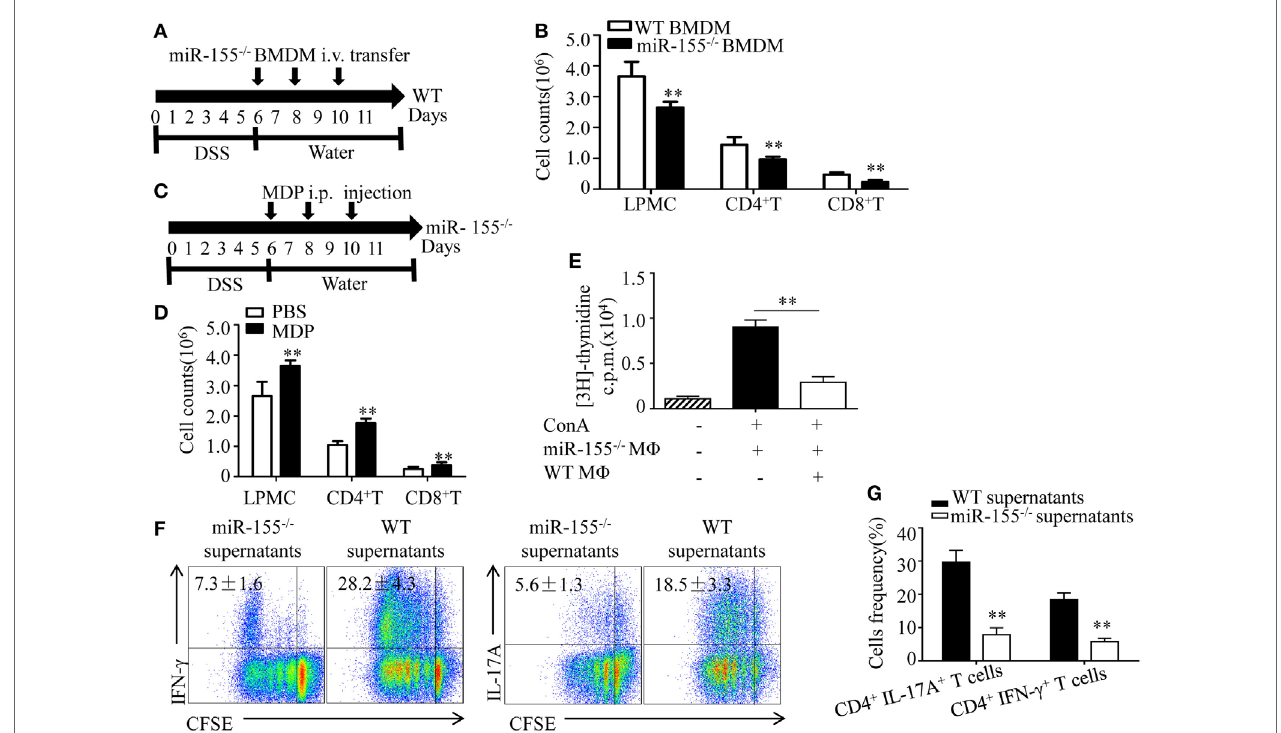
FigUre 5 | miR-155 − / − macrophages inhibit inflammatory cells and shape Th1/Th17 polarization (a,B) WT ( n = 5) mice with dextran sulfate sodium (DSS) colitis were adoptive transferred with miR-155 − / − BMDMs or WT BMDMs (5 million/mouse) as schematic protocol indicated. The total number of LPMCs, CD4 + T cells, and CD8 + T cells of colon tissues at day 11 were counted. (c,D) miR-155 − / − mice ( n = 5) with DSS colitis were i.p. injected with clodronate-liposomes (MDP) or control PBS-liposomes (PBS) as the schematic protocol indicated, and the total number of LPMCs, CD4 + T cells and CD8 + T cells of colon tissues at day 11 were counted. (e) OT-II mice splenocytes with incorporation of [ 3 H]thymidine were cultured in the presence ( + ) or absence ( − ) of ConA, with ( + ) or without ( − ) miR-155 or WT BMDMs, then proliferation was assessed by [ 3 H]thymidine incorporation. (F) CFSE-labeled naive OT-II T cells were cultured with OVA and miR-155 − / − or WT BMDMs culture supernatants for 4 days, and subjected to flow cytometry with gating of CD4 + T cells. (g) Flow cytometry of populations of CD4 + IL-17 + T cells and CD4 + IFN- γ + T cells by OT-II T cells were primed as described in (F) , then allowed to “rest” and re-stimulated for 6 h with anti-CD3 and anti-CD28. Numbers in outlined areas indicate percent cells in the gate. * P < 0.05, ** P < 0.01 vs WT control [Student’s t -test in (B,D,e,g) ]. Data are representative of three independent experiments [mean and SD in (a–D) ]; n = 12–15 mice per group in (B,D) . WT,